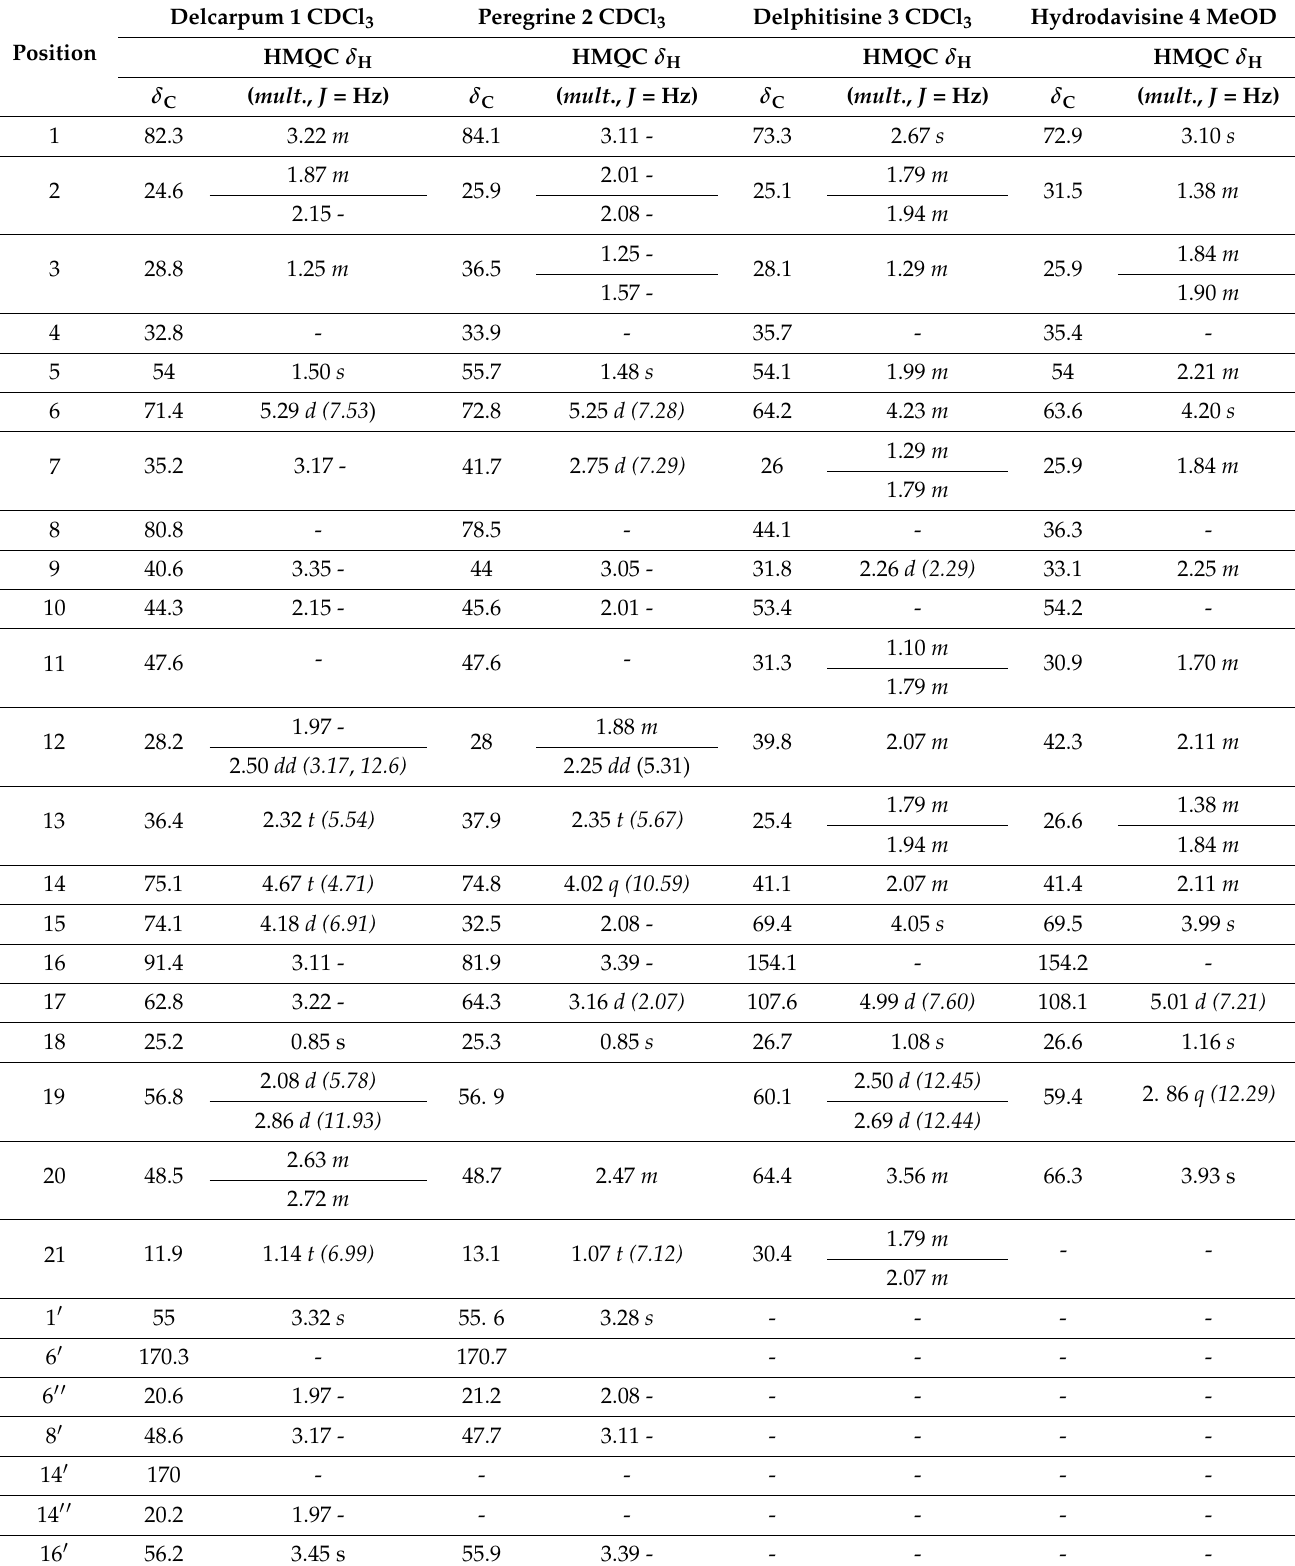
Table 1. 13 C-NMR & HMQC NMR data assignments for Delcarpum ( 1 ), Peregrine ( 2 ), Delphitisine ( 3 ), and Hydrodavisine ( 4